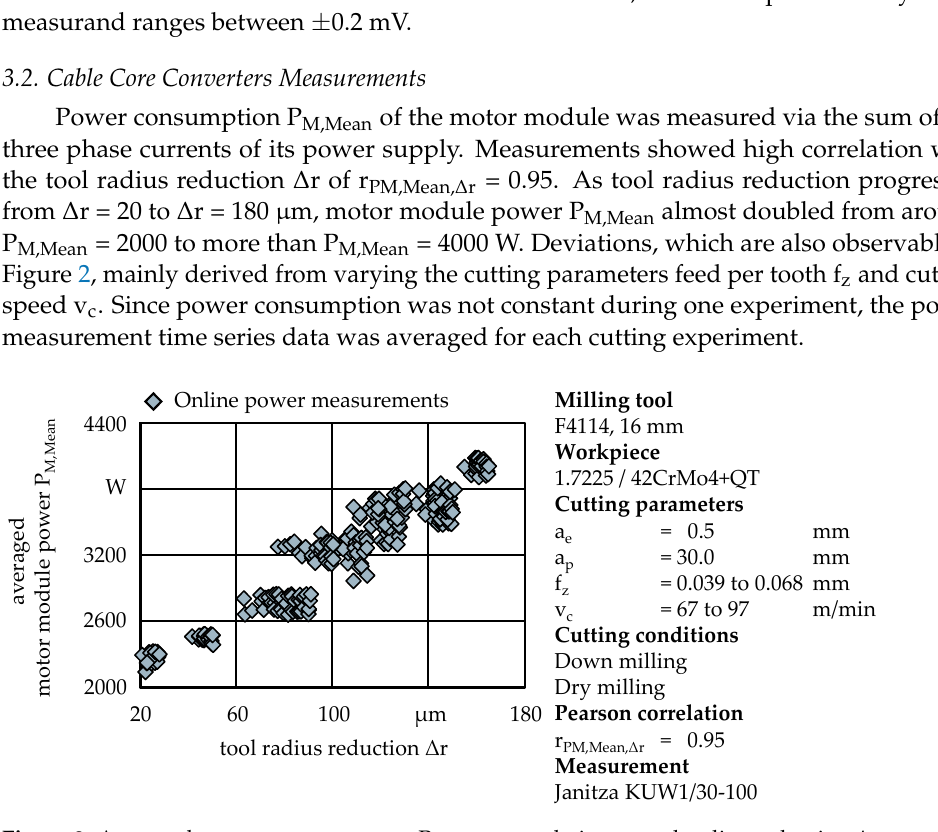
Figure 2. Averaged power measurements P M,Mean correlation to tool radius reduction Δr .